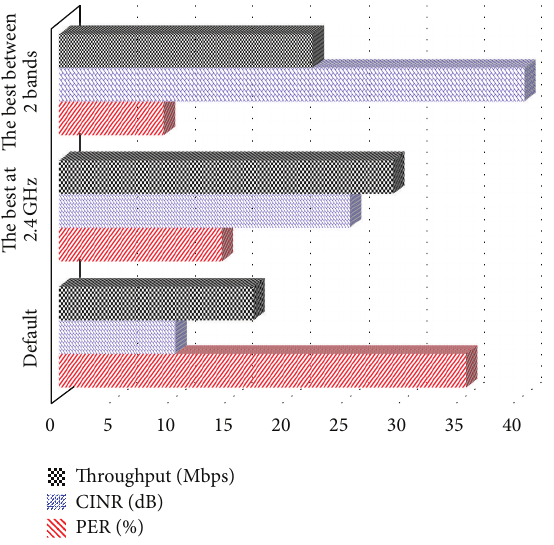
Figure 14: Significant enhancement on the network performance parameters using